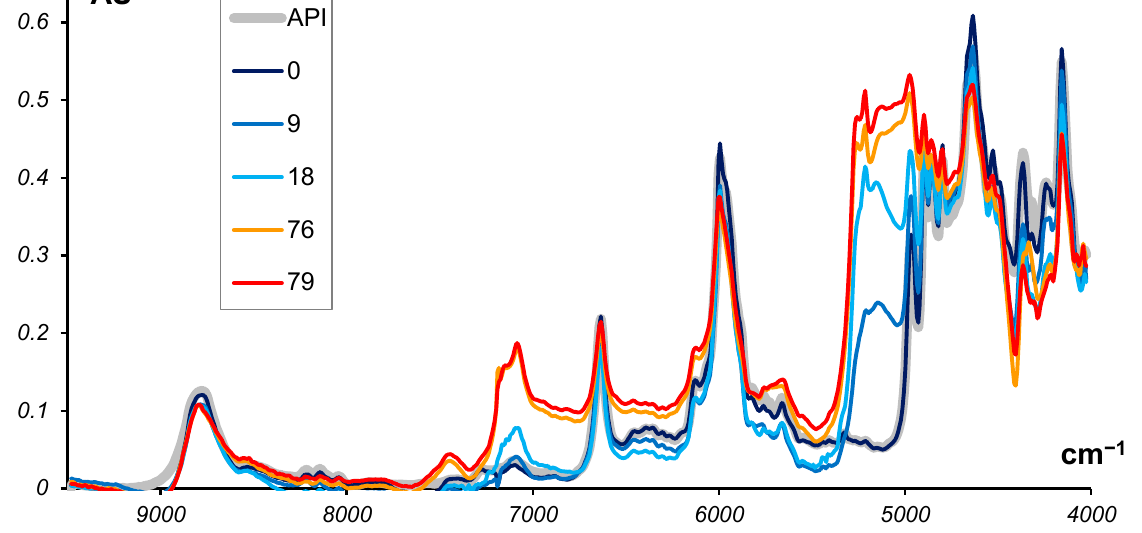
Figure 5. The ‘clean’ spectra of tablets after natural aging at five time points: 0, 9, 18, 76, and 79 months. The spectrum of API is shown as a reference.